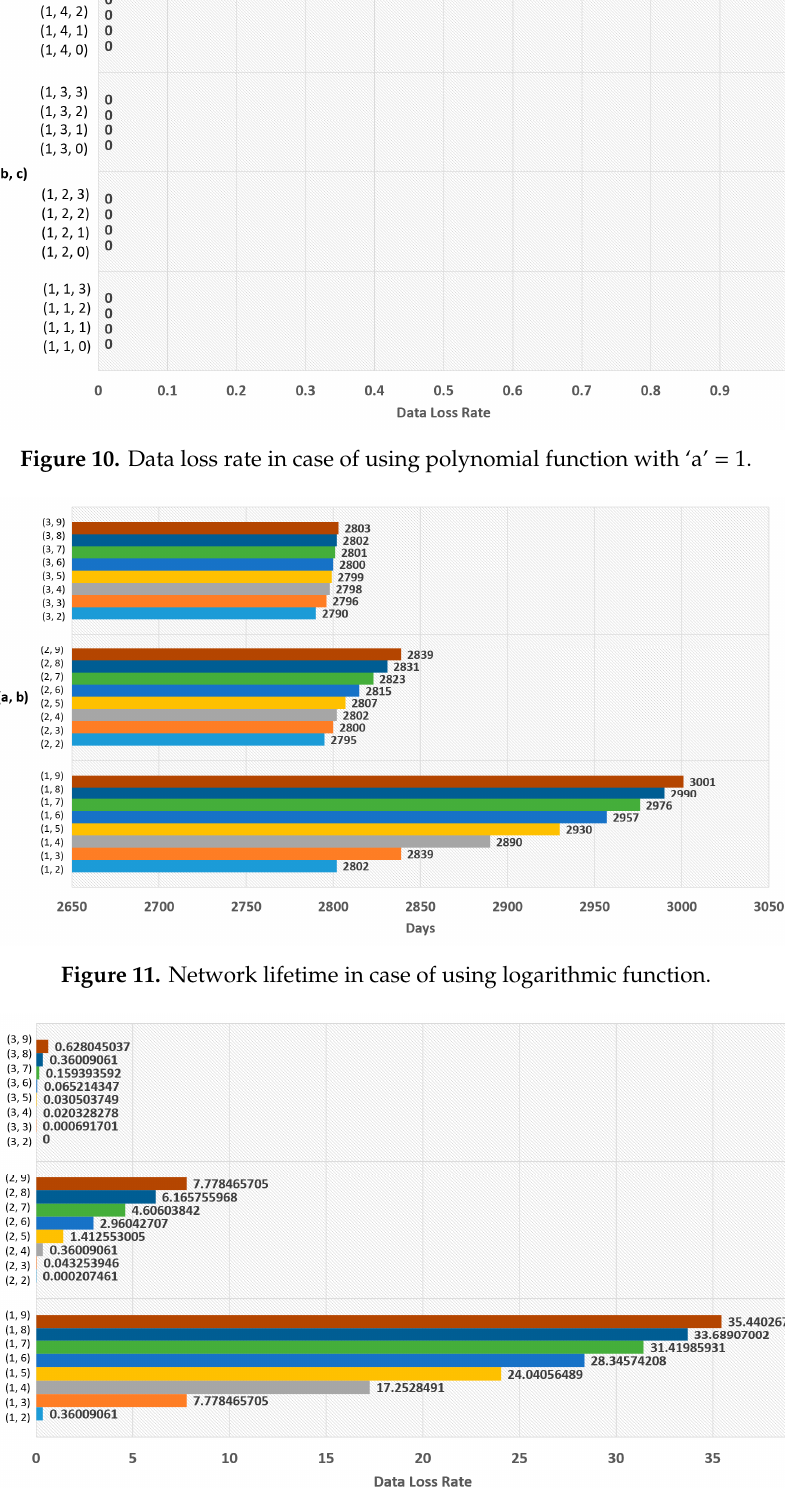
Figure 12. Data loss rate in case of using logarithmic function.